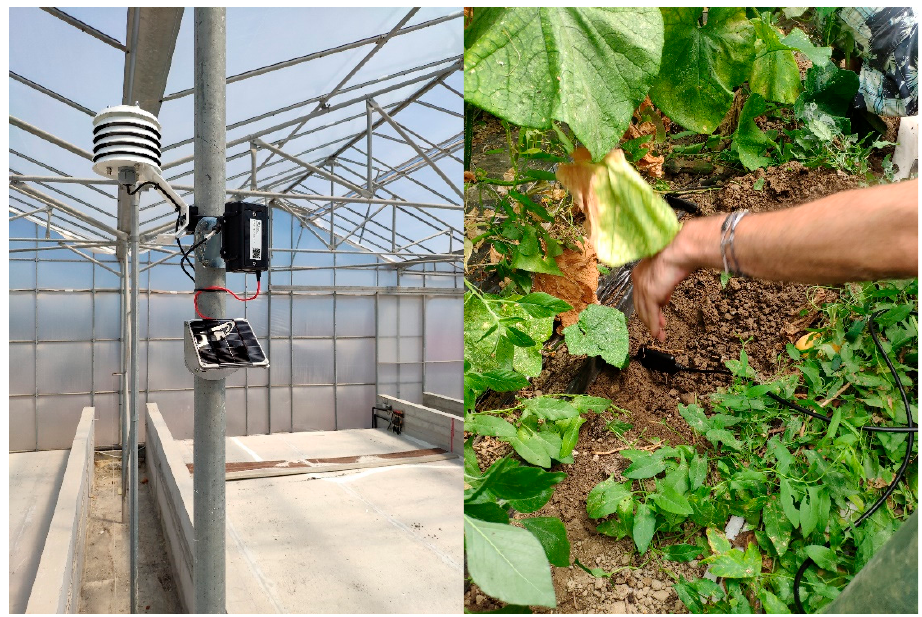
Figure 3. Sensors and components of the QUHOMA platform.